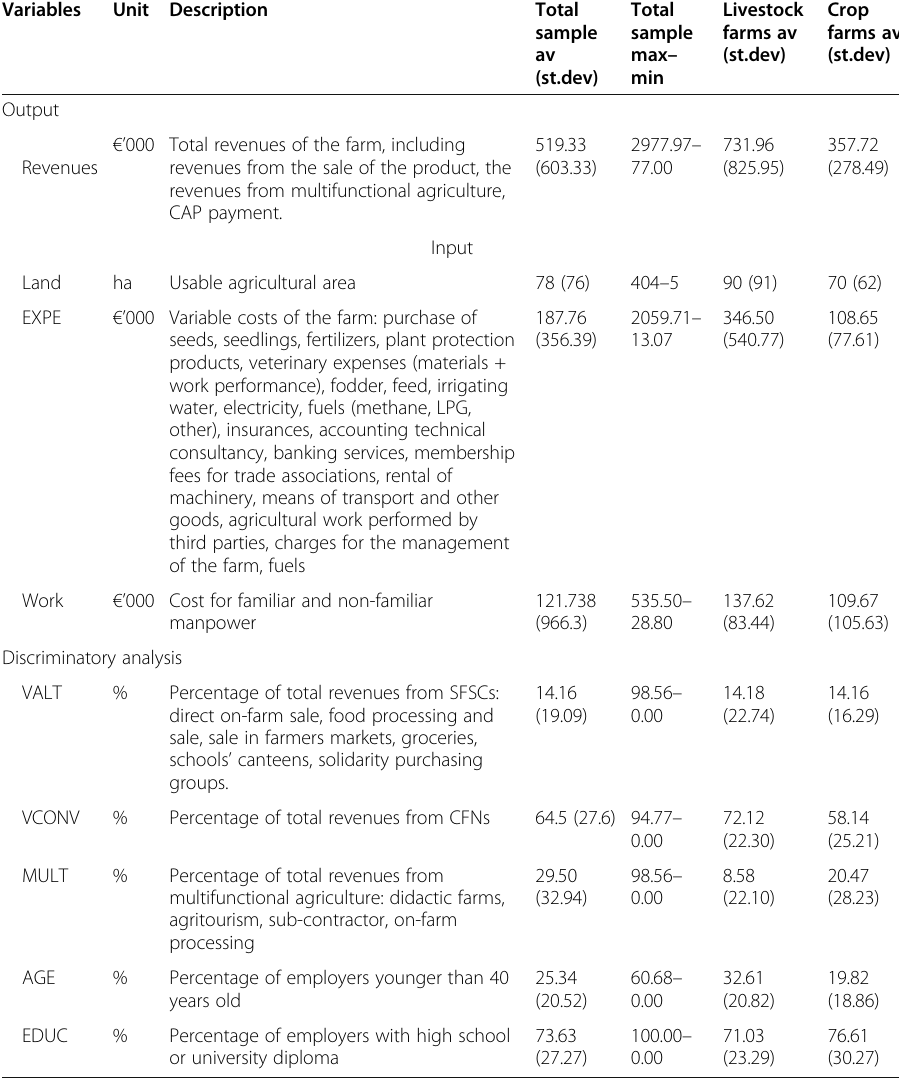
Table 2 Description of the data envelopment analysis ’ input variables and variables of the t -test; average values (av) and standard deviation